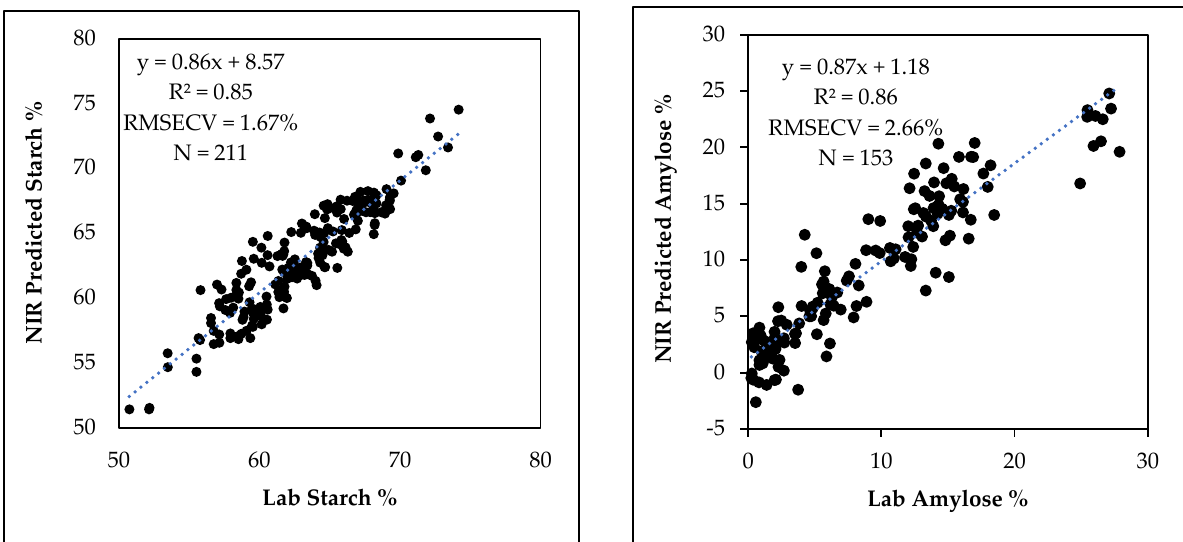
Figure 7. Lab-determined versus NIR predicted final starch ( left ) and amylose ( right ) cross validated calibrations con- structed by combining all spectra in the calibration and validation datasets.